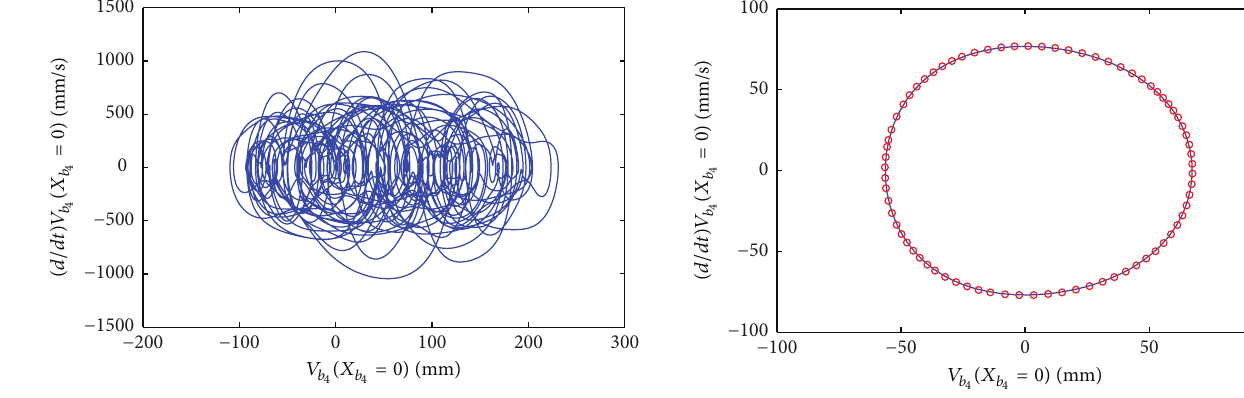
Figure 15: Chaotic response of the midpoint of the deck beam, (0) = 0.3𝛿 𝑞 𝑟 1𝑟 .